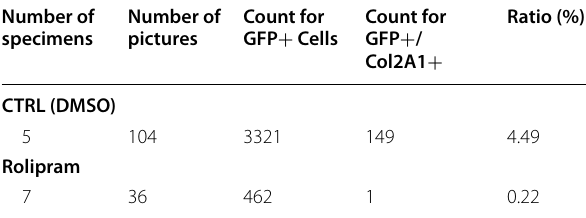
Table 1 The cell count of GFP + Col2a1 + cells in Rolipram treated limbs Number of